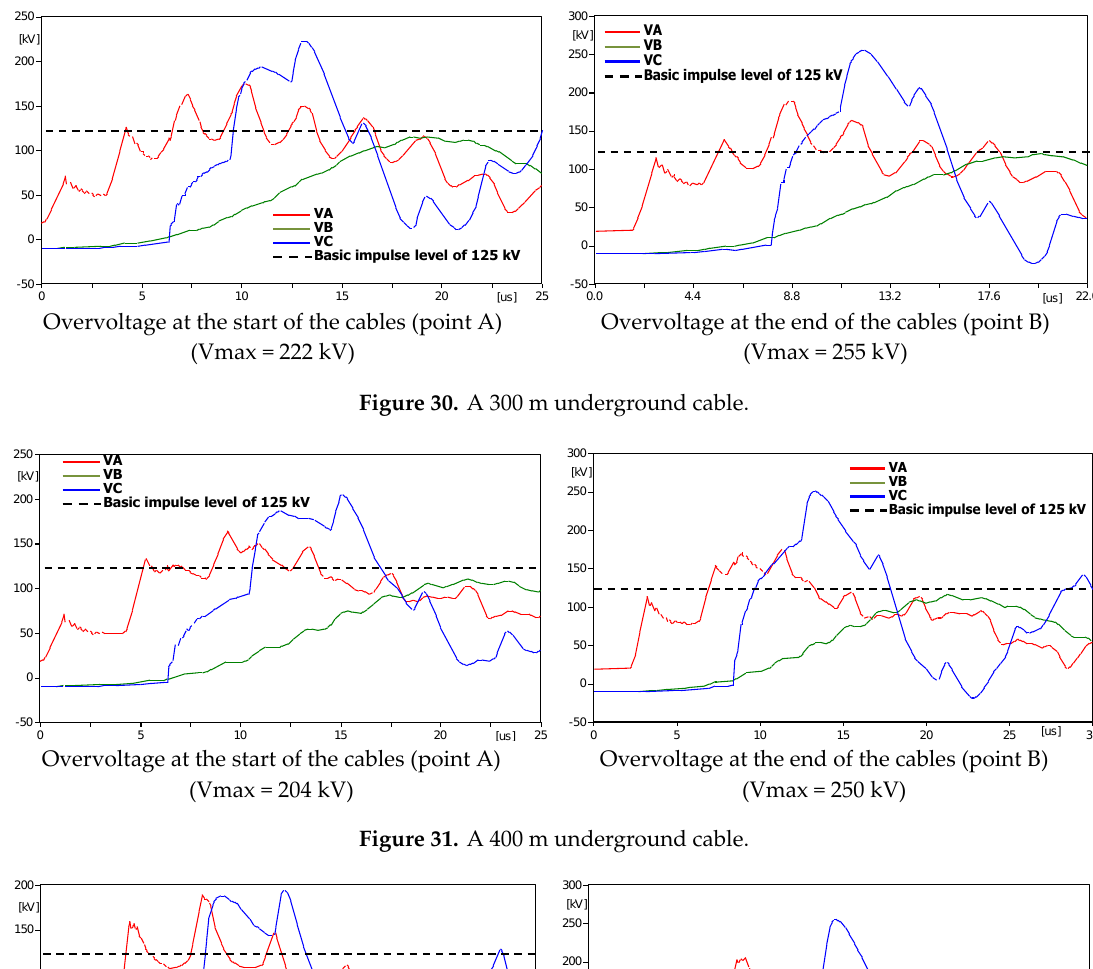
Figure 29. A 2 00 m underground cable.